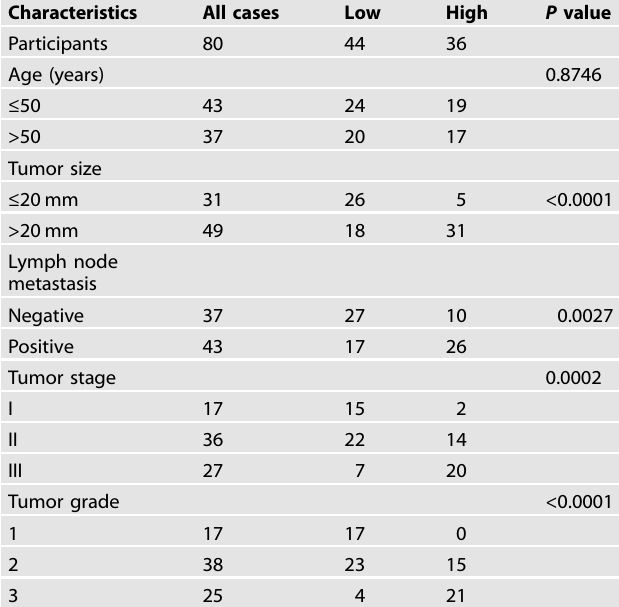
Table 1. Analysis of correlation between NONO expression and clinic parameters of triple-negative breast